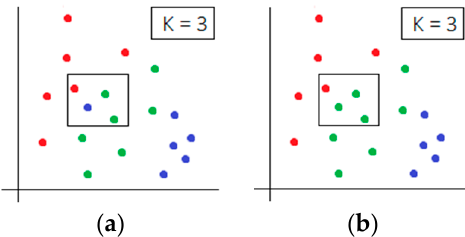
Figure 2. Two consecutive steps of the K-nearest neighbors (KNN) algorithm (K = 3) in a bi-dimensional feature space; ( a ): a blue item has ambiguous clustering, ( b ) the green cluster is assigned to it according to its number and proximity.